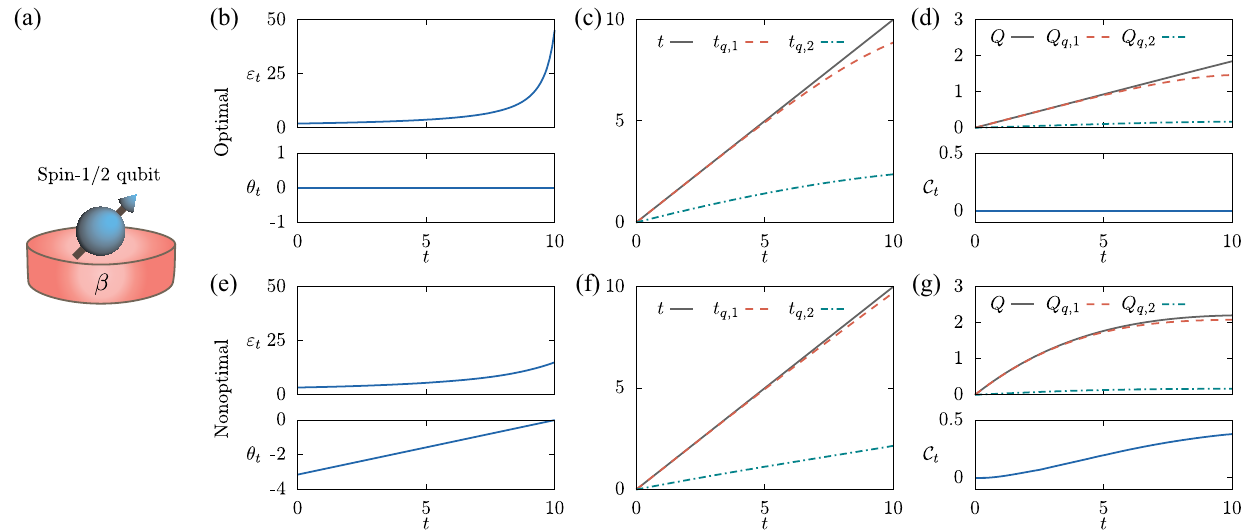
FIG. 6. Numerical illustration of the quantum thermodynamic speed limits and finite-time Landauer principle for both optimal and nonoptimal protocols. (a) Schematic of the spin- 1 = 2 qubit, which is coupled to a heat bath at inverse temperature β . (b),(e) Time variations of the control parameters of the optimal and nonoptimal protocols. (c),(f) Numerical verification of the speed limits ≥ t t ≥ t and (d),(g) finite-time Landauer principle Q ≥ Q q; 1 q; 2 parameters are fixed as β ¼ 10 , γ ¼ 0 . 1 , and τ ¼ 10 . The weighting factor λ is set such that ð 1 − λ Þ = λ ¼ 10 3